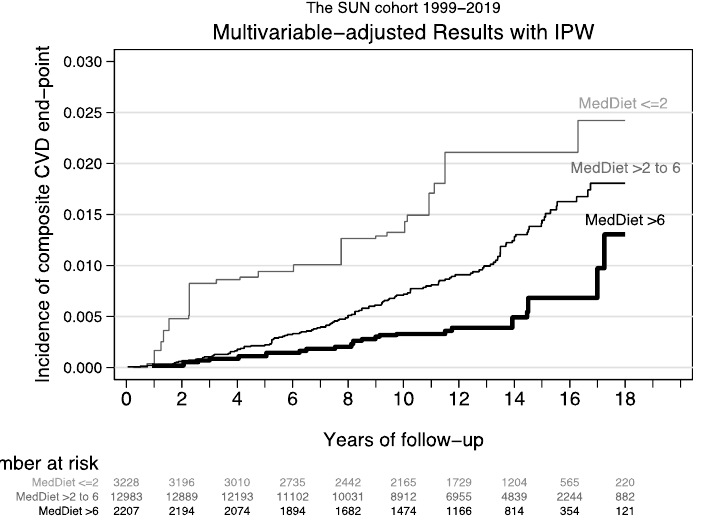
Figure 3. Multivariable adjusted curves of absolute cumulative incidence of CVD according to baseline adherence to the MedDiet (3 categories of the MDS). Confounding was adjusted using IPW methods.